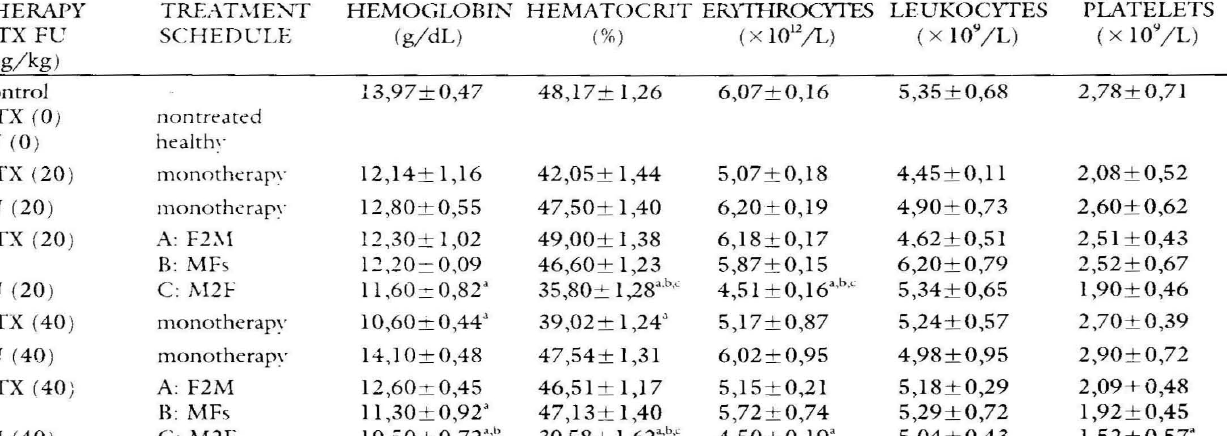
Table 1. Effect o f comhined MTX/ FU therapy o n the values o f peripheral blood morphotic elements in healthy BDF, m.ice; according to difte rent schedules THERAPY